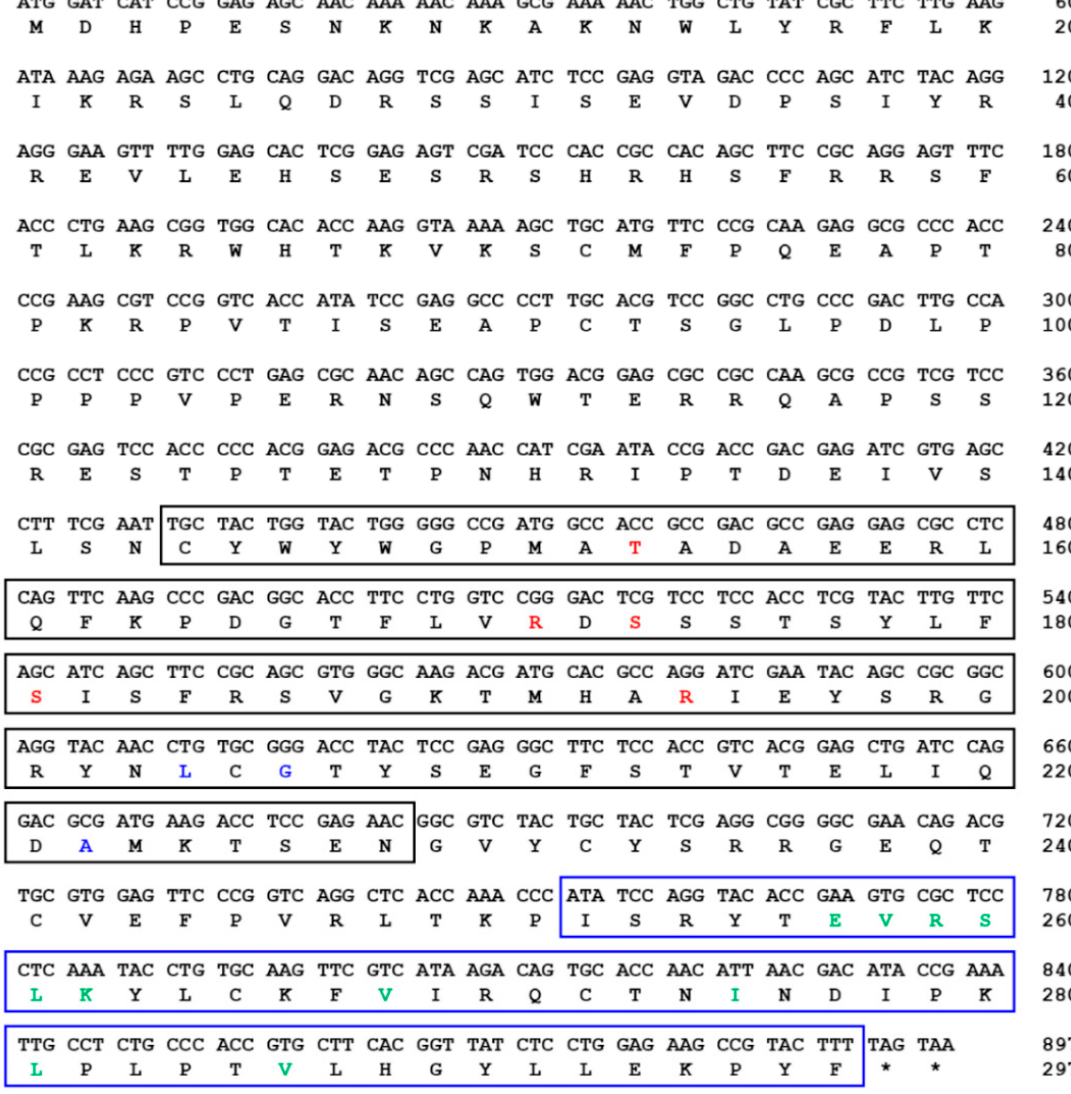
Figure 2. The nucleotide and deduced amino acid sequence of T. molitor SOCS6 (TmSOCS6). The SH2 and SOCS box domains are shown in black and blue boxes, respectively. The phosphotyrosine binding pocket, hydrophobic binding pocket, and putative elongin B/C interaction residues are highlighted in red, blue, and green text, respectively.